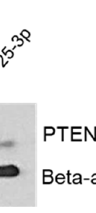
Figure 6. miR ‐ 25 ‐ 3p decreases endometriotic epithelial 12Z cell PTEN protein